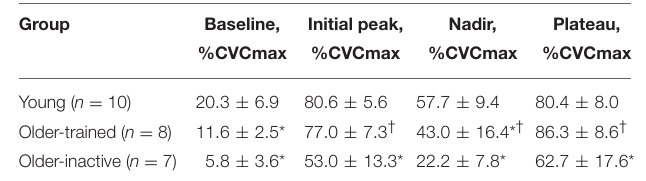
TABLE 3 | Response characteristics of the cutaneous vasodilation during the first 5min of local skin heating to 42 ◦ C. Group